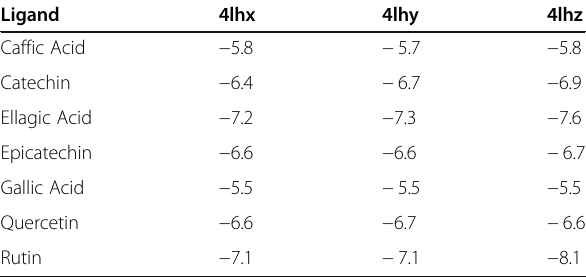
Table 1 Affinity score of ligand with Human Rab8b proteins Ligand